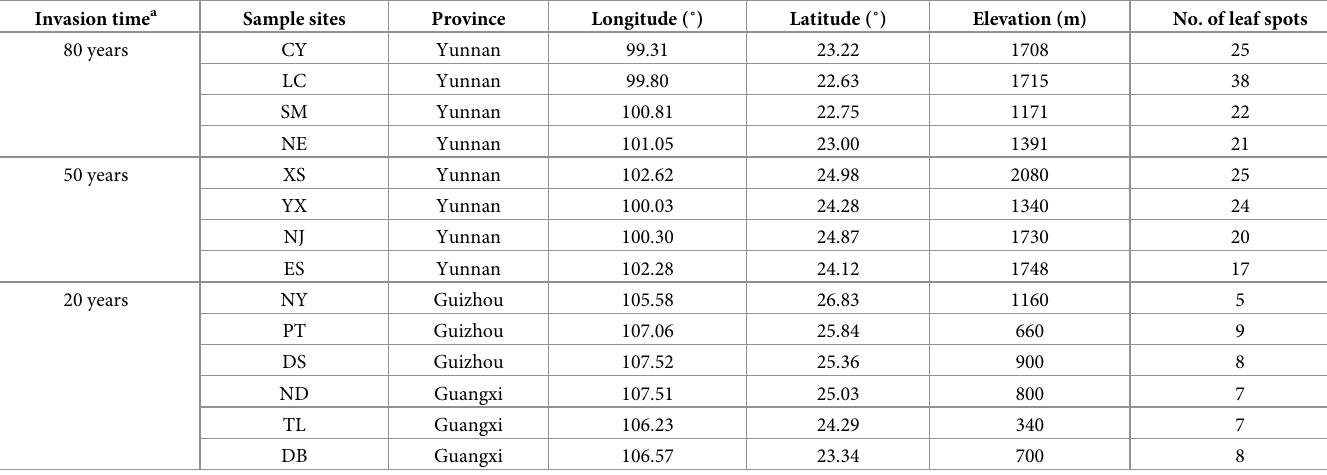
Note: a Invasion time for each site is from [18]. CY represents Cangyuan County, LC represents Lancang County, SM represents Simao city, NE represents Ninger County, XS represents Xishan District in Kunming city, YX represents Yunxian County, NJ represents Nanjian County, ES represents Eshan County, NY represents Nayong County, PT represents Pingtang County, DS represents Dushan County, ND represents Nandan County, TL represents Tianlin County, and DB represents Debao